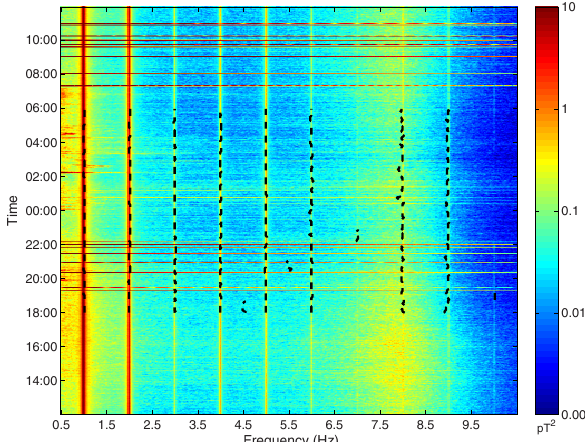
Figure 7. Example spectrogram of data from 25 to 26 May 2013 with very strong contamination from man-made interference (verti- cal lines).